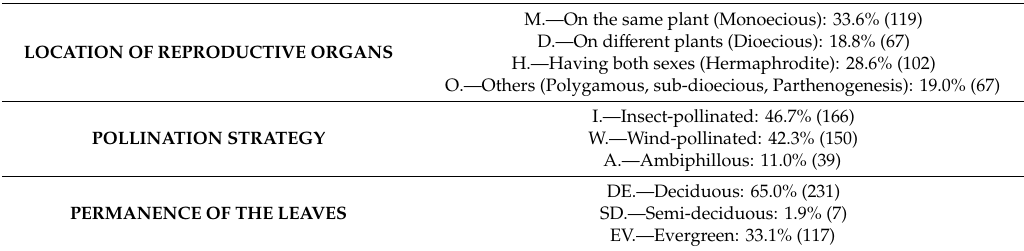
Table 2. Reproductive characteristics, pollination, and permanence of leaf attributes in the tree species of the Mediterranean parks considered in this study.